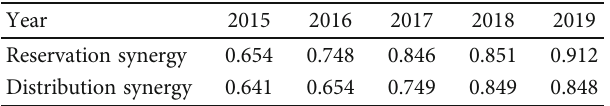
Table 7: Order degree of the CME management synergy resource subsystem in Henan Province.